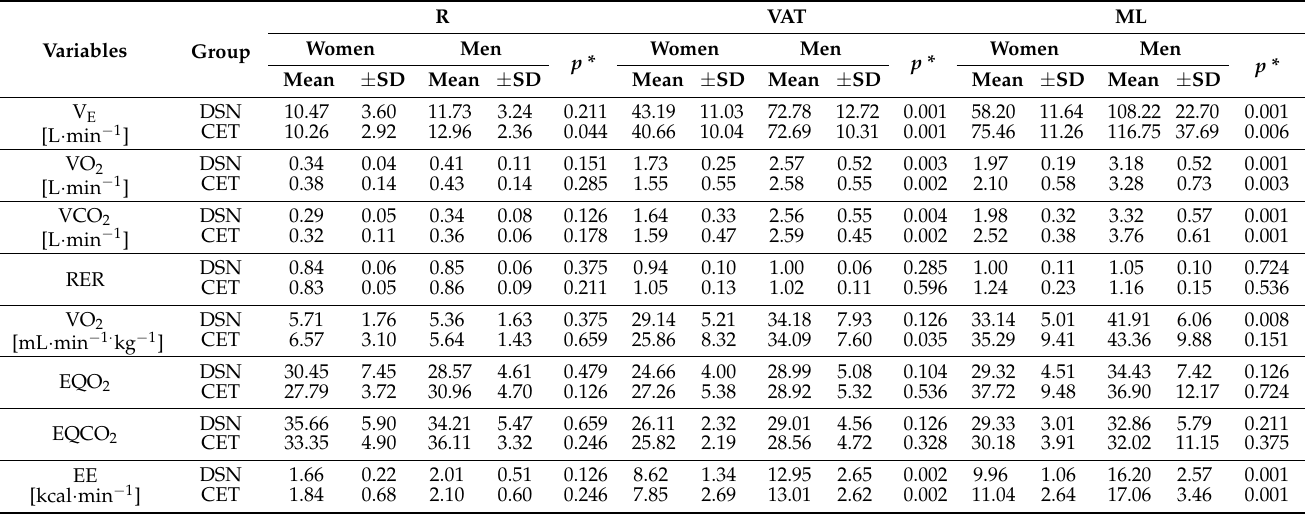
Table 4. Gender comparison of the respiratory and metabolic values obtained during DSN and CET by women (n = 7) and men (n = 11).